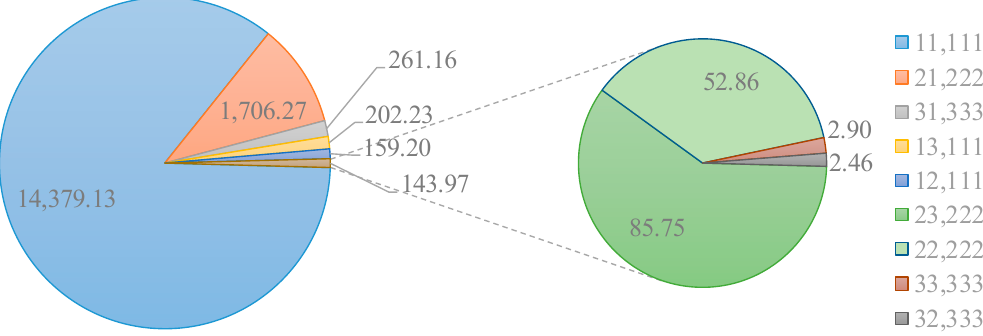
Figure 5. Ecosystem demand service overlay relationships.